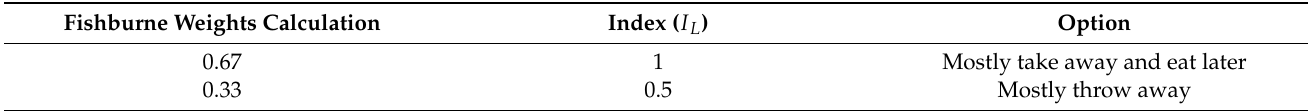
Table 4. Index system for “food leftovers”